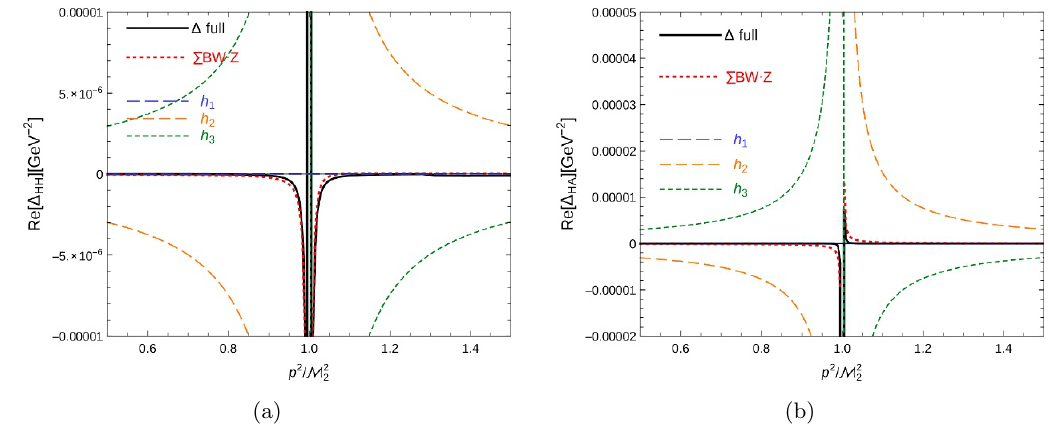
Figure 8 . Real parts of (a) the diagonal propagator (cid:1) HH ( p 2 ) and (b) the o(cid:11)-diagonal propagator (cid:1) HA ( p 2 ) depending on the complex momentum p 2 around M 2 as in (cid:12)gure